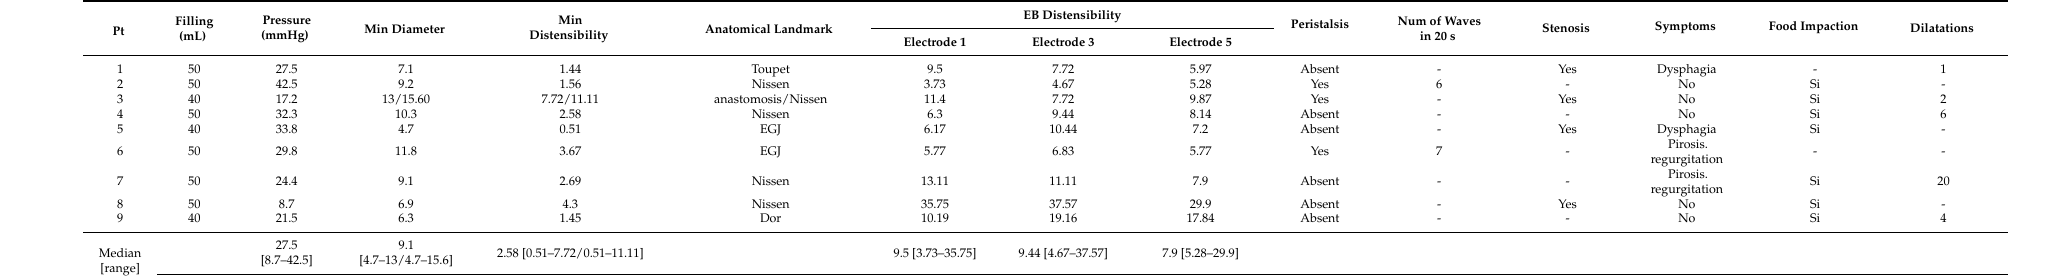
Table 3. Endoflip™ data. Distensibility parameters, diameters and peristalsis compared to the clinical